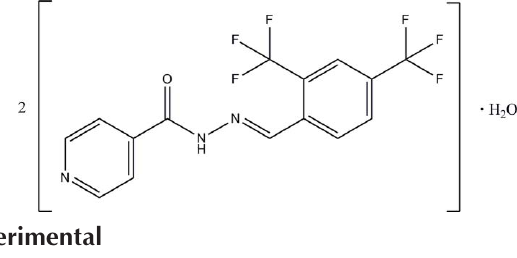
Bruker APEXII DUO CCD area- detector diffractometer Absorption correction: multi-scan ( SADABS ; Bruker, 2009) T min = 0.914, T max = 0.980